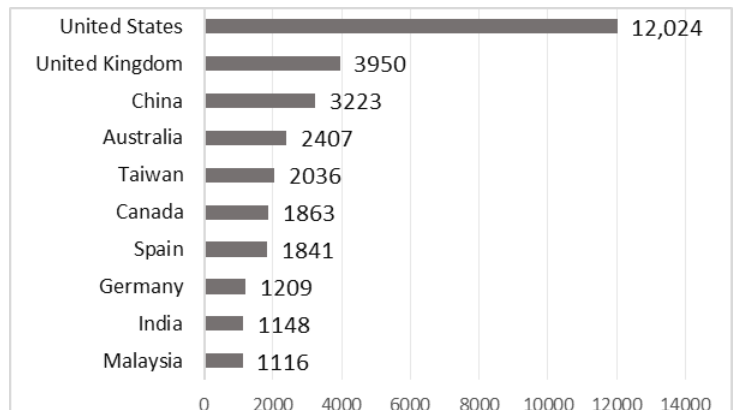
Figure 3 Top 10 Countries With the Most Published Articles